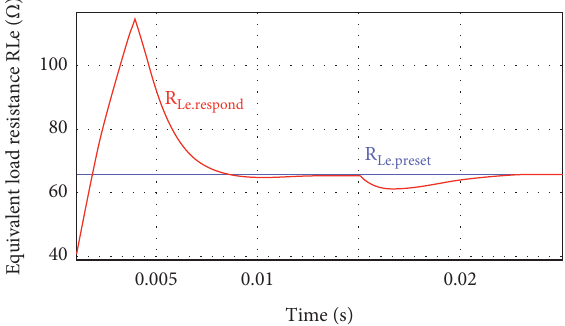
Figure 8: Simulation results of load impedance response according to a preset value.